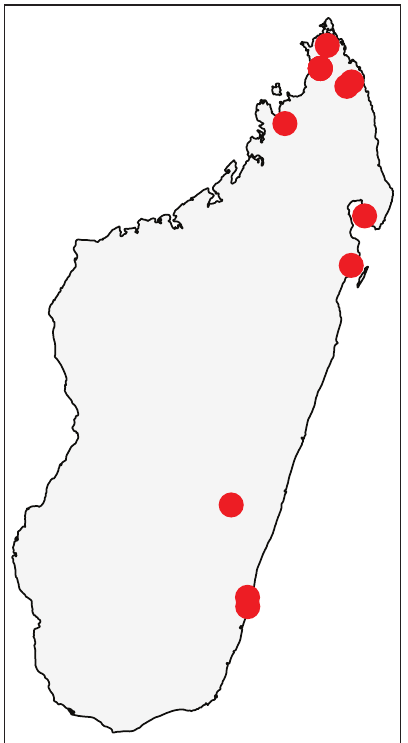
Figure 45. Geographic distribution of Nesomyrmex sellaris sp. n.. The known localities of N. sellaris sp. n. in